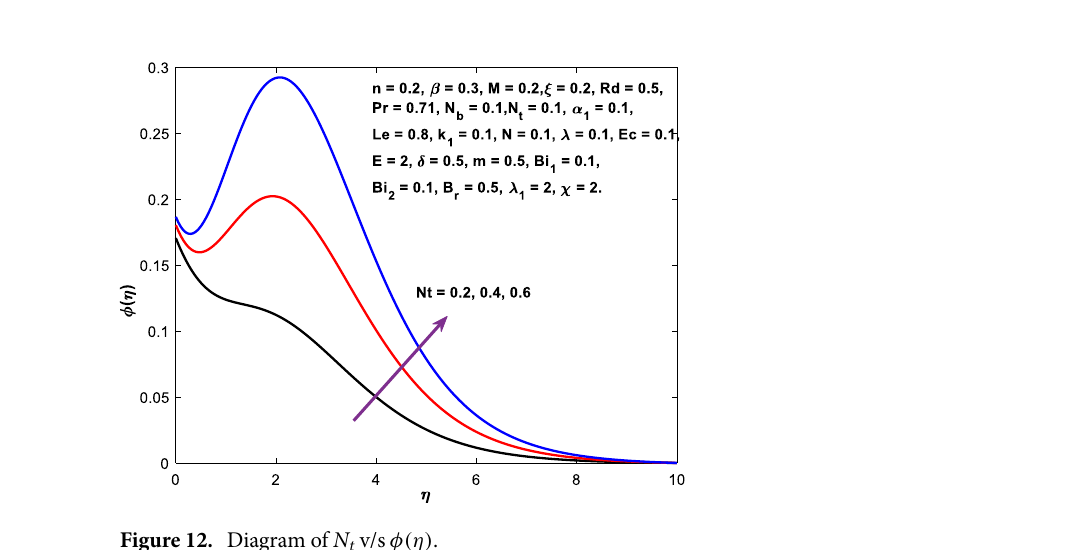
Figure 12. Diagram of N t v/s φ(η) .